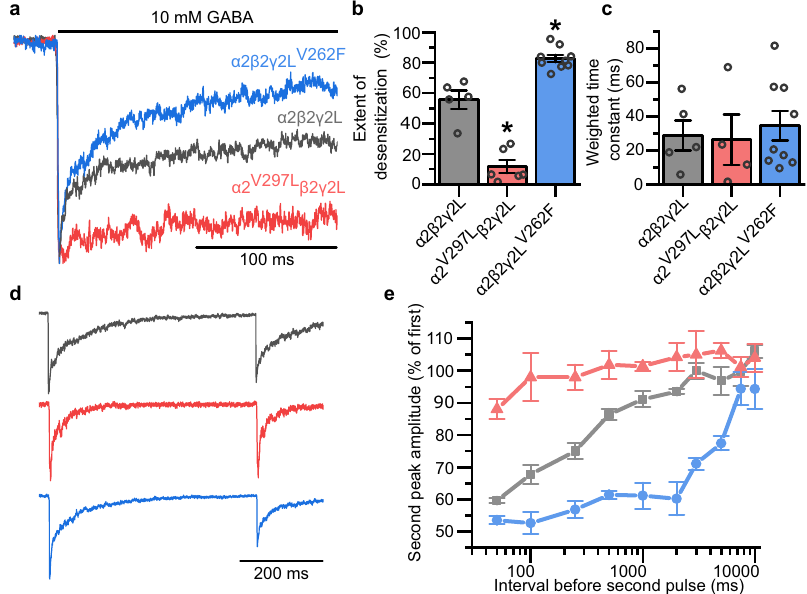
Fig. 2 α 2 V297L and γ 2 V262F alter the desensitization of GABA A Rs. a Average GABA (10 mM)-activated currents showing macroscopic desensitization of wild-type (black) mutant α 2 (red) and γ 2L (blue) GABA A Rs in outside-out patches pulled from transiently transfected HEK293 cells expressing α 2 β 2 γ 2L wild-type and mutated subunits, as indicated. b Extents of desensitization caused by 10 mM GABA measured as the % depression of the peak to steady- state GABA current, n = 5, 6 and 9 patches for receptors containing α 2 WT , α 2 V297L and γ 2L V262F , respectively (one-way ANOVA: F (2, 17) = 92.45, p = 7.3 × 10 − 10 ; Tukey test (wt, α 2 V297L ): p = 3.4 × 10 − 6 ; Tukey test (wt, γ 2L V262F ): p = 0.0004). c Weighted decay time constants for exponential fi ts to macroscopic desensitization curves for α 2 WT , α 2 V297L and γ 2L V262F containing GABA A Rs (one-way ANOVA: F(2,15) = 0.18, p = 0.84). n = 5, 4 and 9 patches, respectively; note that these are the same patches as panel ( b ), but weighted time constants could not be calculated for two of the α 2 V297L patches due to insuf fi cient decay of the currents. d Averaged GABA currents recorded from outside-out HEK cell patches expressing GABA A Rs (colour coded as in a ) showing responses to two 1 ms pulses of 10 mM GABA separated by 500 ms. e Re-sensitization of the peak GABA current measured from the relative amplitude of the current evoked by the second GABA pulse over a series of interevent intervals, n = 4 patches for each. Source data are provided as a Source data fi le for Fig. 2.